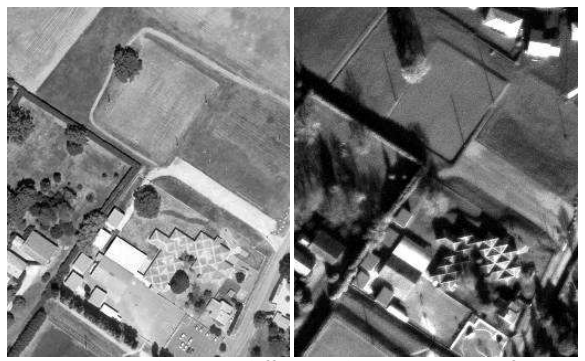
Figure 8 : Radiometric differences between image reference and PHR acquisition